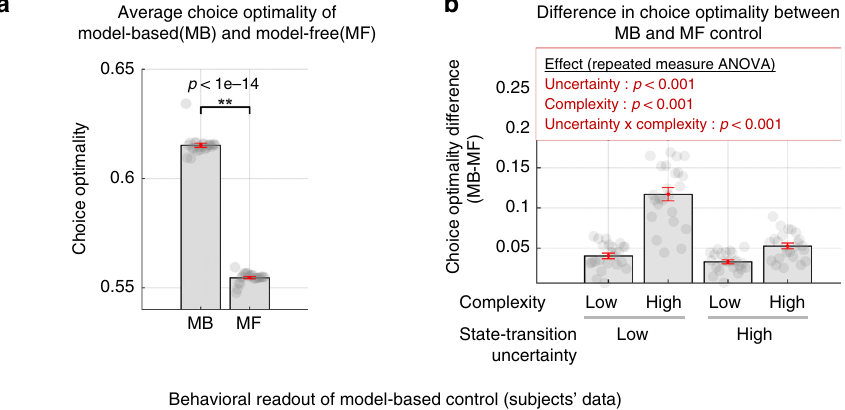
Fig. 5a and Methods section for more details of model speci fi cation): The fi rst factor in the hypothesis set is the effect of complexity on arbitration control. We considered different ways in which complexity could impact on the allocation of MB vs MF control, including whether the modulation was excitatory or inhibitory, i.e.